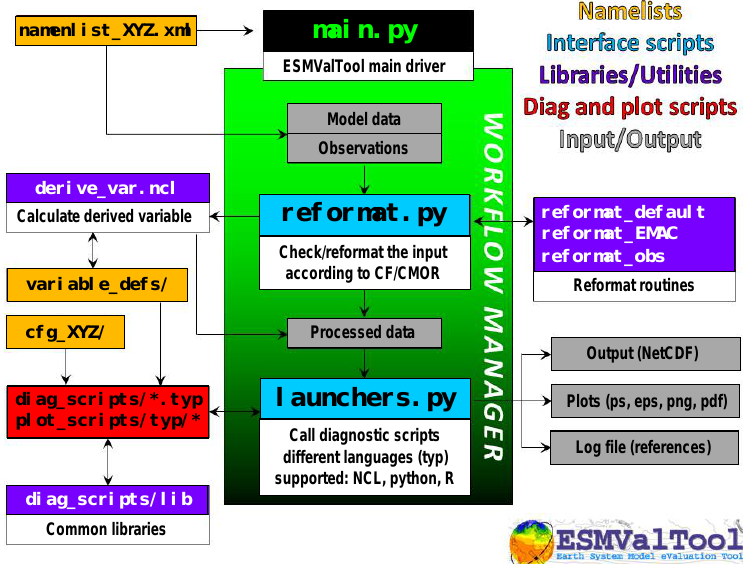
Figure 1. Schematic overview of the ESMValTool (v1.0) structure. The primary input to the workflow manager is a user-configurable text namelist file (orange). Standardized libraries/utilities (purple) available to all diagnostics scripts are handled through common interface scripts (blue). The workflow manager runs diagnostic scripts (red) that can be written in several freely available scripting languages. The output of the ESMValTool (grey) includes figures, binary files (netCDF), and a log file with a list of relevant references and processed input files for each